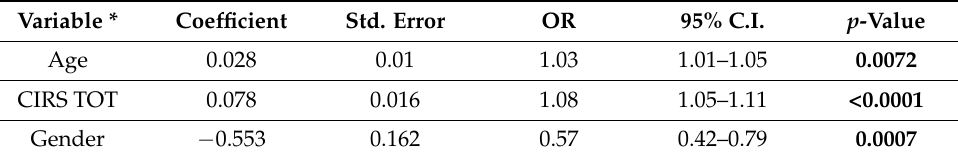
Table 8. Logistic regression stepwise Hb < 12 g/dL.